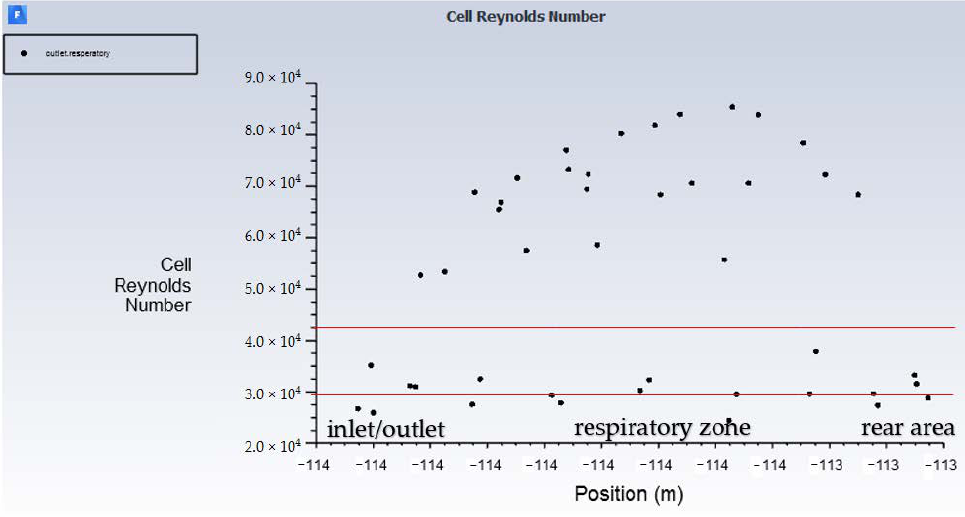
Figure 9. Variation of the Reynolds number in the longitudinal section of the object.